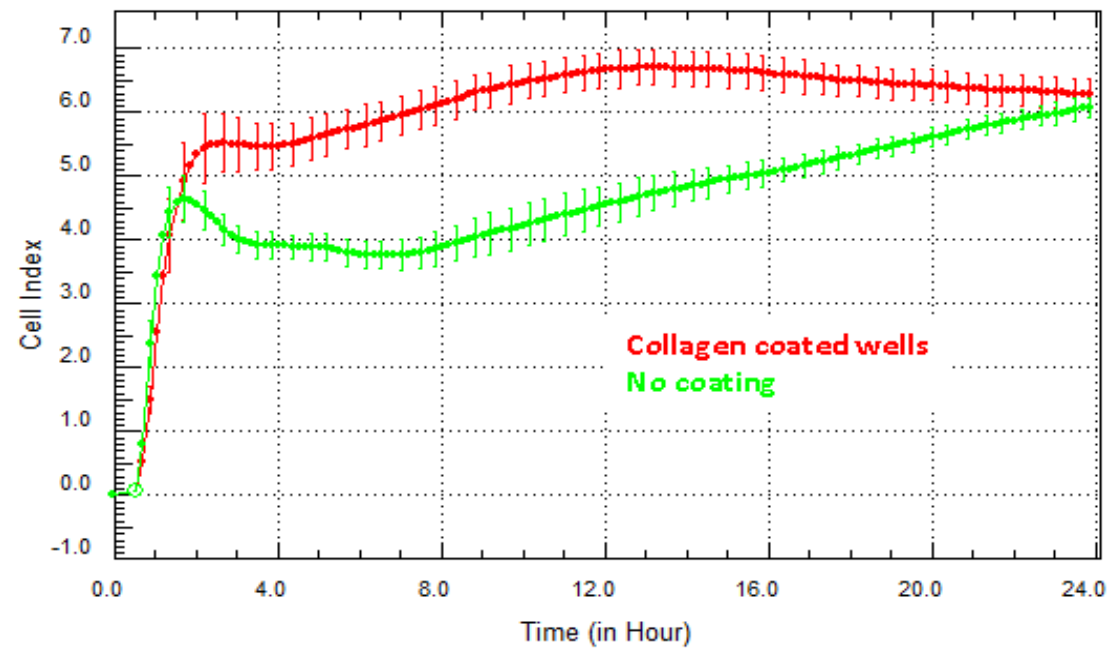
Figure 4. Optimisation of matrix coating for best growth conditions. There are a multitude of factors that can influence the growth and viability of cells. This figure highlights the influence of collagen (red curve) on the adhesion of human brain cerebral microvascular cell (hCMVECs) endothelial cells. Collagen is a major component of the basal lamina of the blood brain barrier structure. Here, the endothelial cells achieve a higher level of adhesion faster than those not grown on a matrix. Mean Cell Index value from >4 wells ±